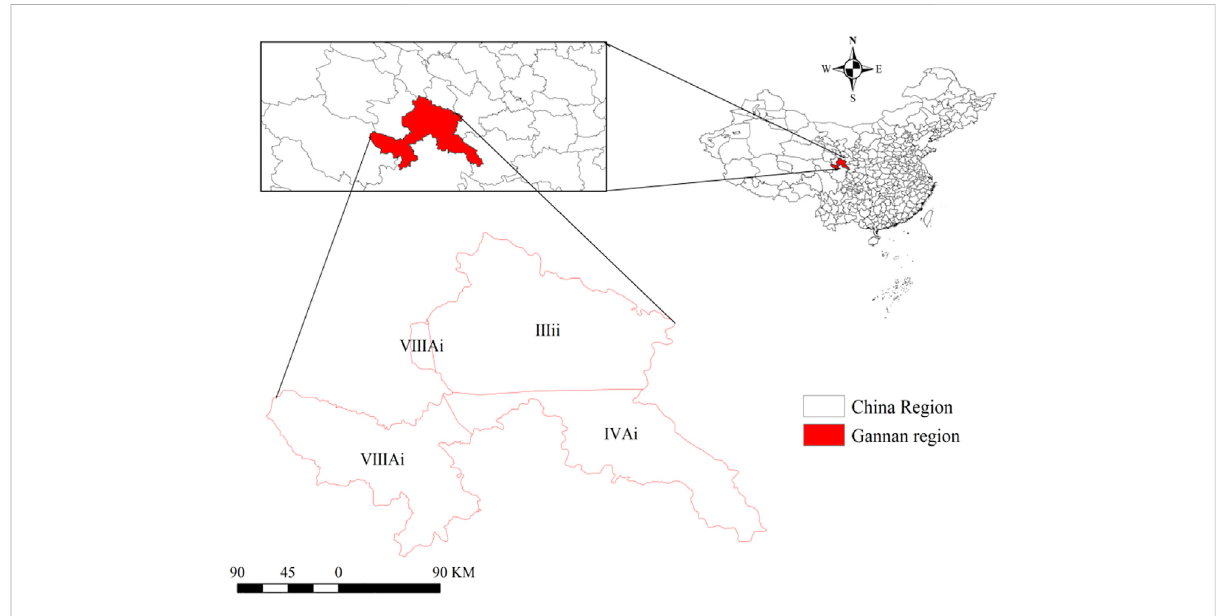
FIGURE 1 Spatial distribution of the meteorological observation station in Gansu,